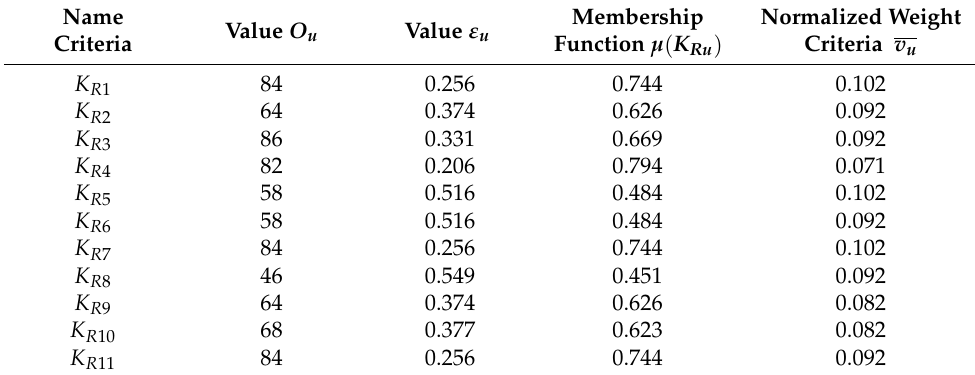
Table 3. Calculation results for the model M R